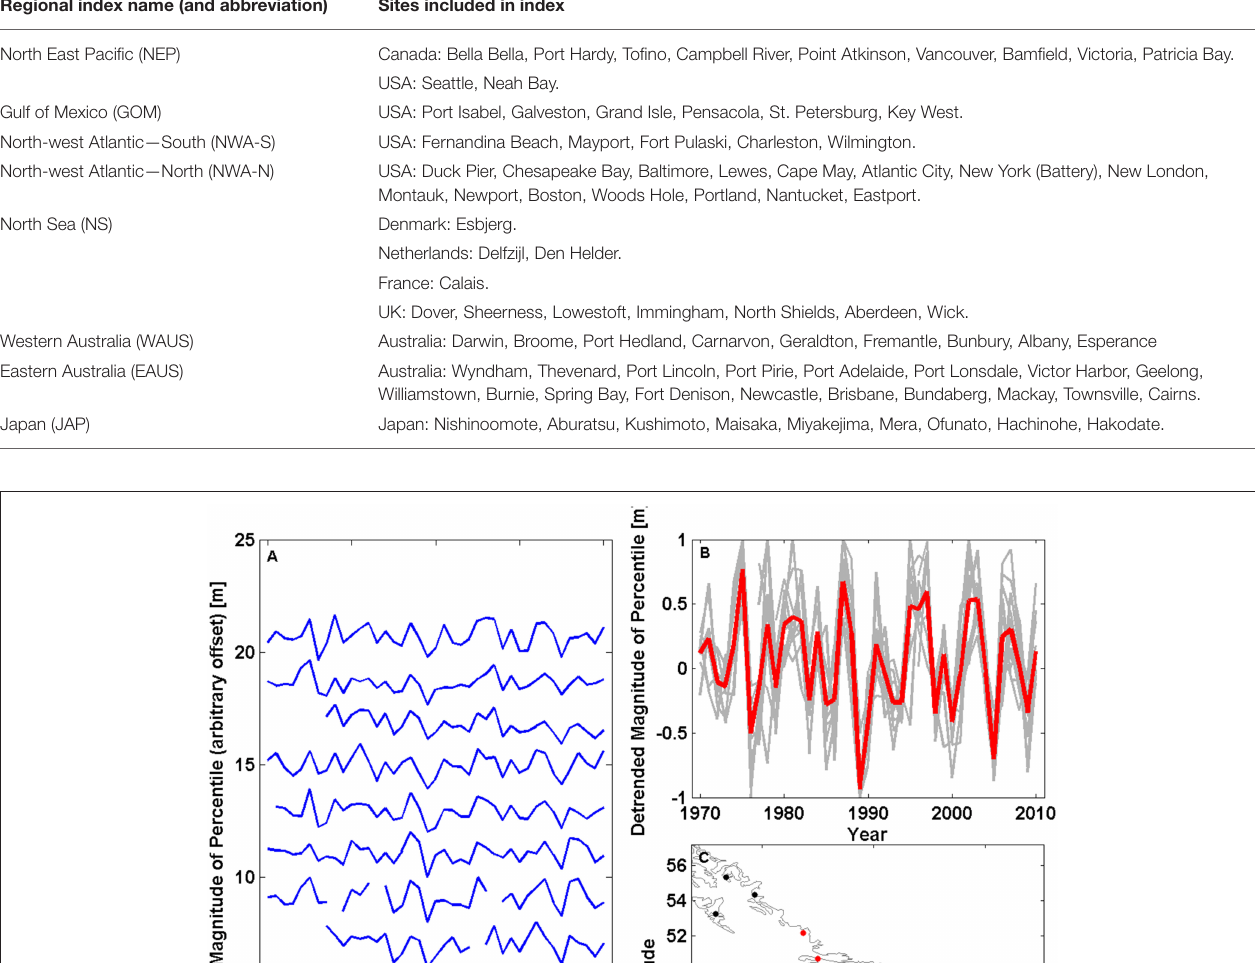
(NWA-S), north-west Atlantic North (NWA-N), North Sea (NS), west Australia (WAUS), east Australia (EAUS), and Japan (JAP). An example of the creation of a regional index is shown in Figure 9 for the north-east Pacific. The de-trended, normalized time-series from each of the 11 selected sites in the region are plotted in Figure 9A , with an arbitrary offset. These time series are overlaid in Figure 9B . The thicker red lines shows the regional time-series that has been created by averaging the de-trended, normalized time-series for each of the 11 sites. The locations of the 11 sites used to calculate the regional index are